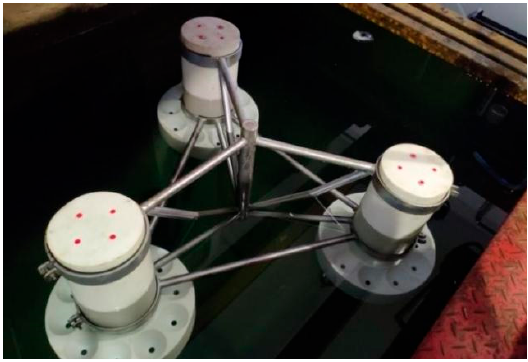
Figure 5. Model of the pedestal.